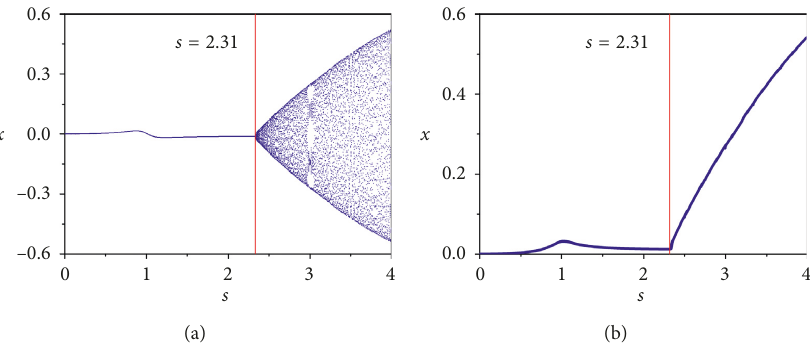
Figure 3: (a) The bifurcation diagram and (b) the amplitude-frequency response curve of the rotor/seal system in the x